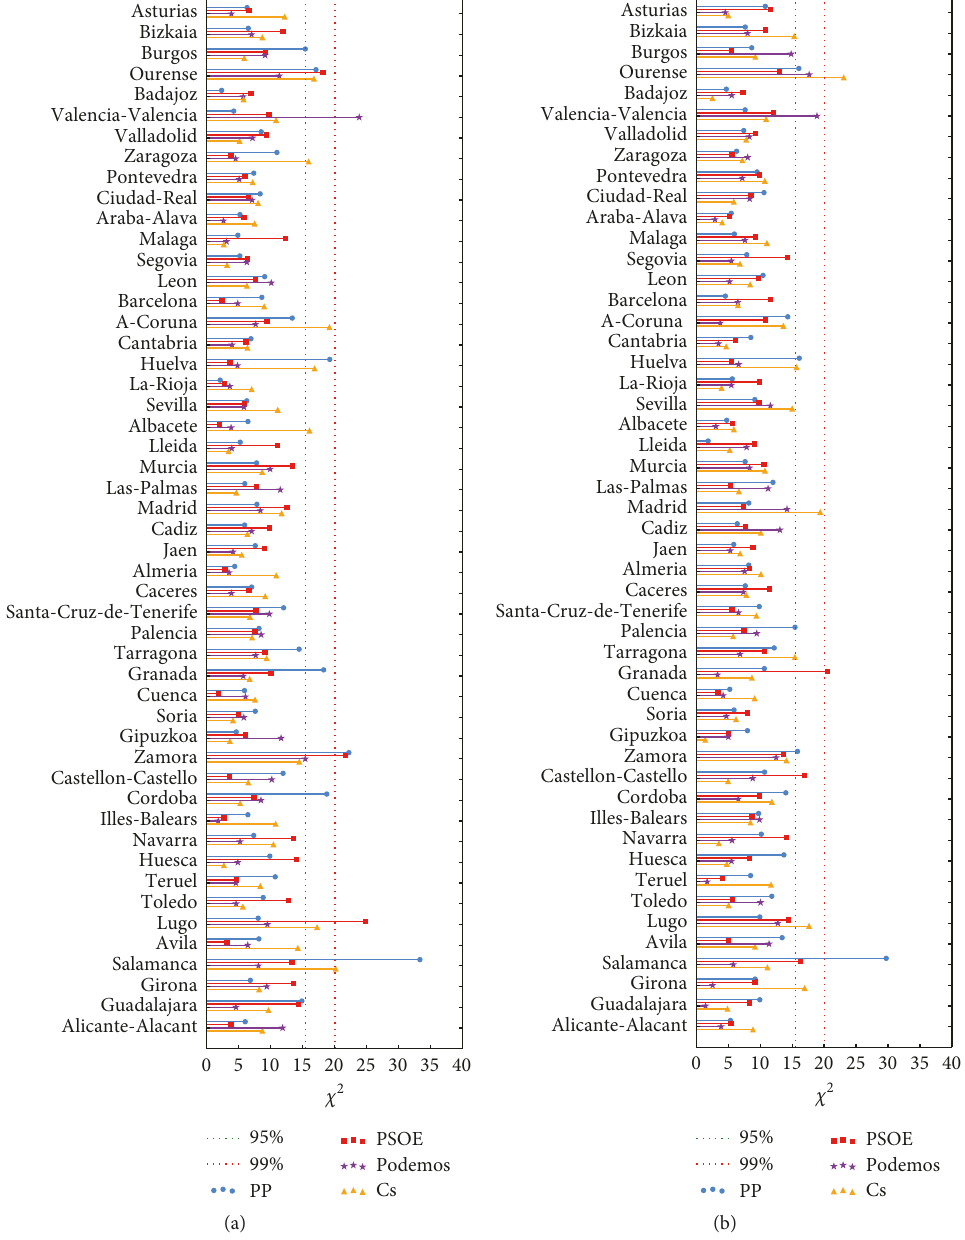
Figure 10: 𝜒 2 values of the goodness of fit to 1BL for 2015 (a) and 2016 (b) at the aggregation level of precincts. In every case the critical values for rejection at the 95 and 99% confidence level are shown. For a large majority we accept conformance to Benford’s law. Note that results are inconsistent with the hypothesis test based on MAD as reported in Figure